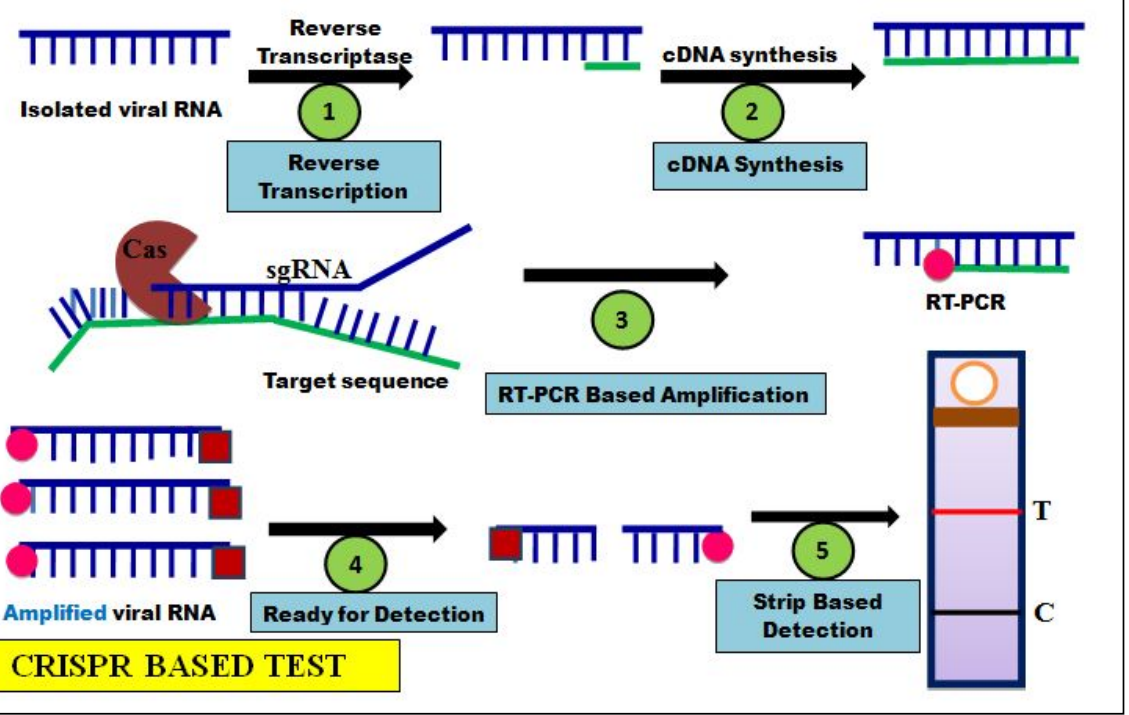
Figure 4. CRISPR/Cas-based detection of SARS-CoV-2 infection: ( 1 ) reverse transcription of isolated viral RNA; ( 2 ) reverse transcription for the synthesis of cDNA; ( 3 ) CRISPR-mediated genome editing (identify and cleave) actat the precise sequence of viral RNA SARS-CoV-2 genome. Both Sherlock and Detector of the CRISPR tool convert viral RNA to DNA (isothermal amplification), which activates nuclease enzyme activity (Cas-12/13) to cleave the target sequence (pink colored symbols indicate DNA polymerase;red colored symbols indicates primer); ( 4 ) loading of the sample (fluorescence RNA reporter) on to strip for detection of the specific viral RNA sequence; ( 5 ) the number of bands visible on the strip (lateral flow) represents whether the test is positive or negative for SARS-CoV-2 infection.